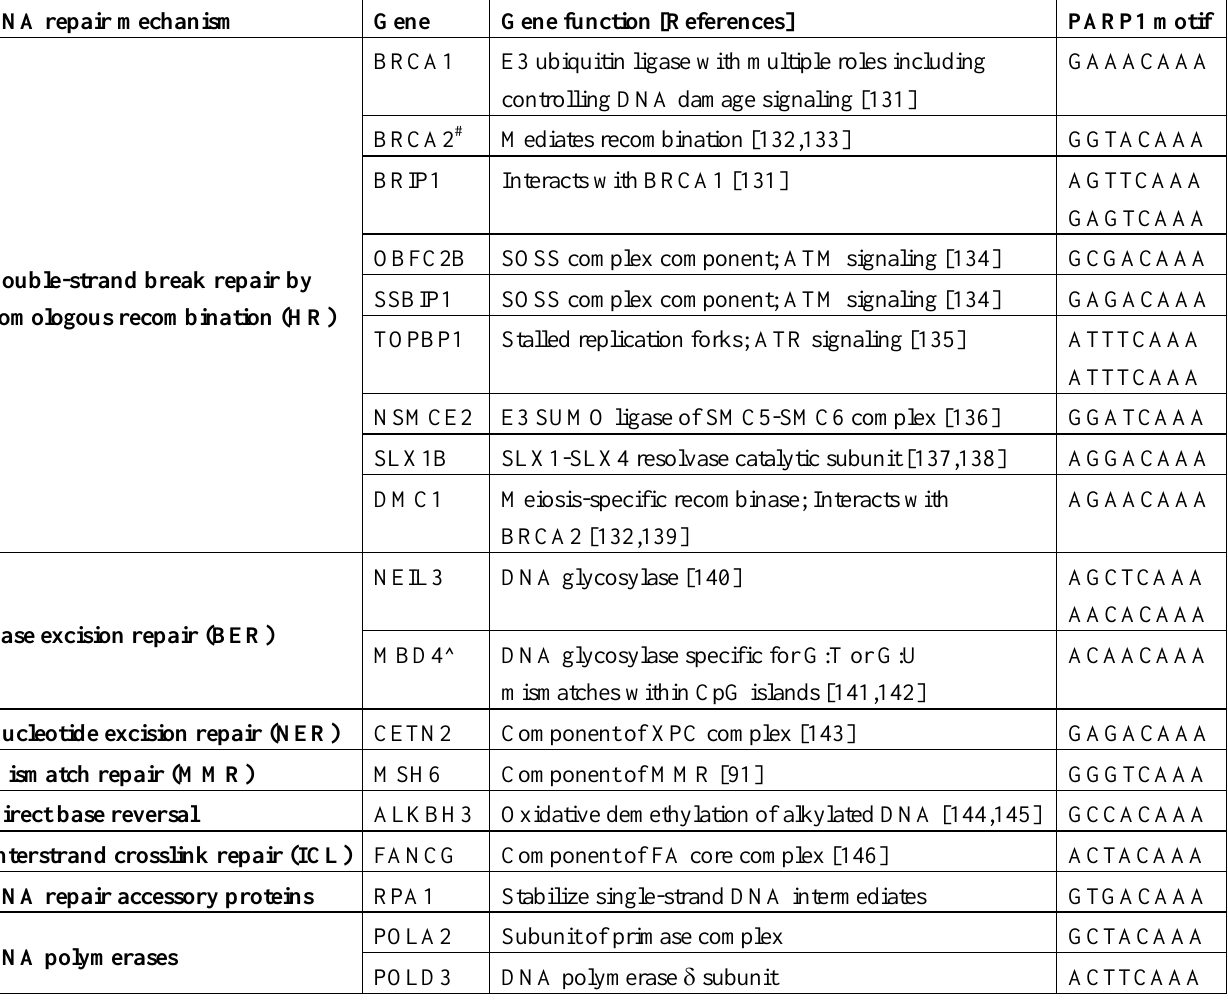
Table 2. Genes involved in DNA repair that possess the PARP1 binding motif. DNA repair